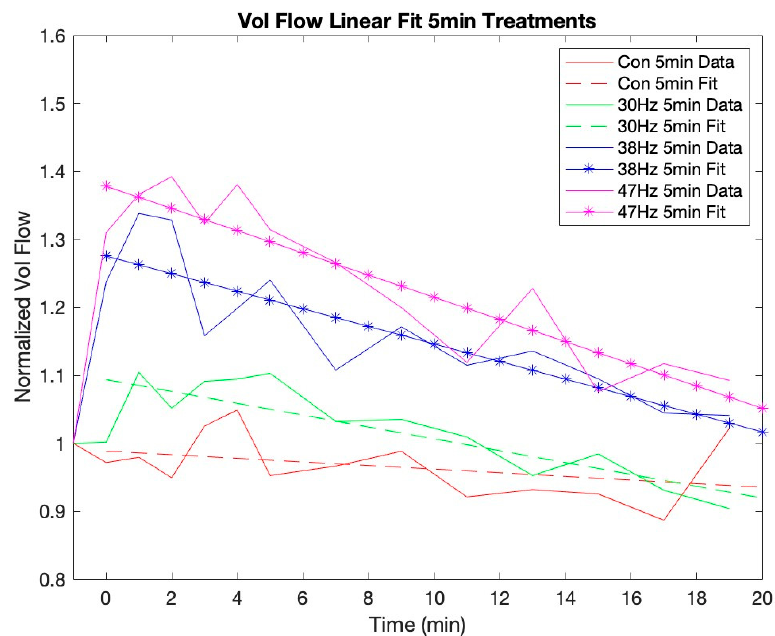
Figure 4. Linear recovery for volume flow with 5-min conditions. Note: 38Hz and 47Hz 5min fit denotes statistical significance of linear data fit for post-vibrations.